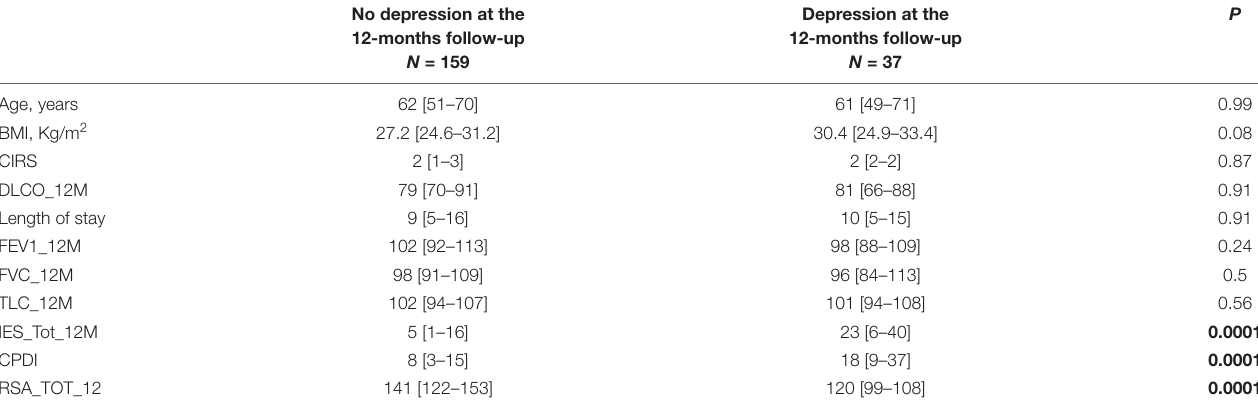
TABLE 4 | Comparison of independent variables.